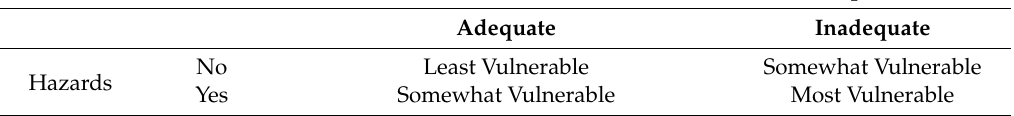
Figure 1. Conceptual Framework of OHS